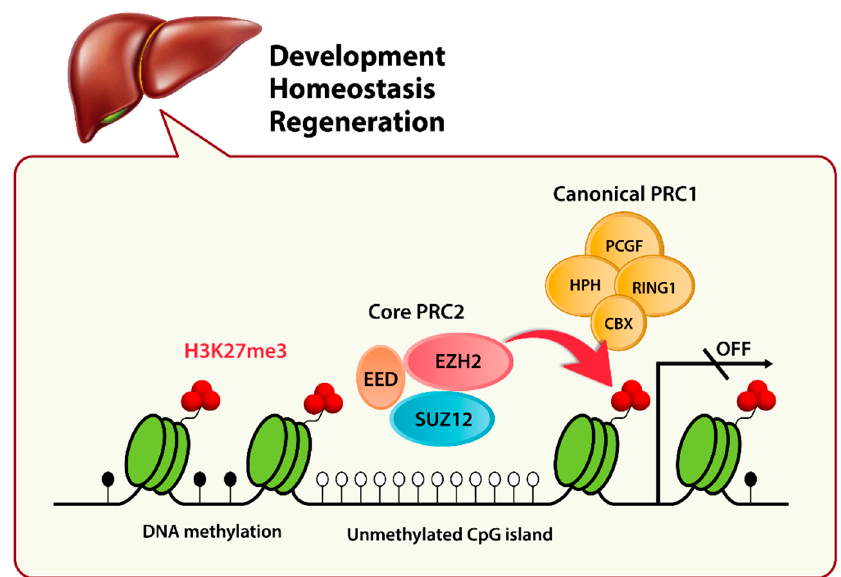
Figure 1. Role of EZH2 in the liver. The core polycomb repressive complex 2 (PRC2) contains suppressor of zeste 12 (SUZ12), embryonic ectoderm development (EED), and the enzymatic catalytic subunit EZH2. PRC2 is recruited to unmethylated CpG islands in repressed genes. EZH2 catalyzes trimethylation on Lys 27 of histone H3 (H3K27me3). H3K27me3 can act as a docking site for